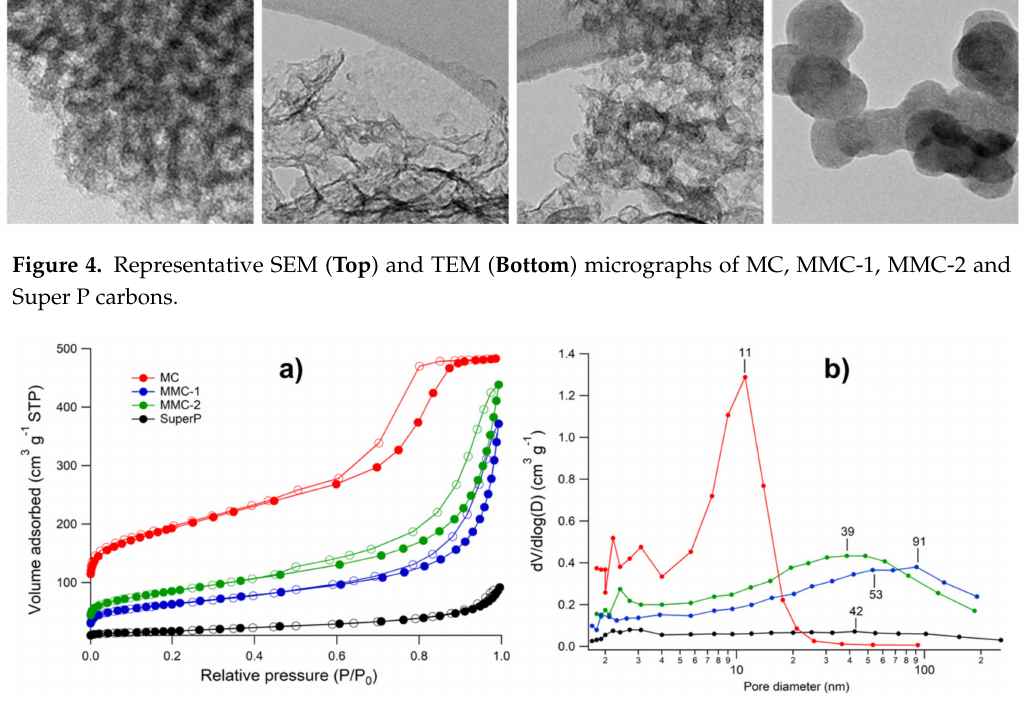
Figure 5. ( a ) N 2 adsorption / desorption isotherms at − 196 ◦ C of MC, MMC-1, MMC-2 and Super P mesocarbons and ( b ) their corresponding BJH pore size distributions. Table 1. Textural data of carbons. Abbreviations: S BET , Brunauer–Emmett–Teller (BET) surface